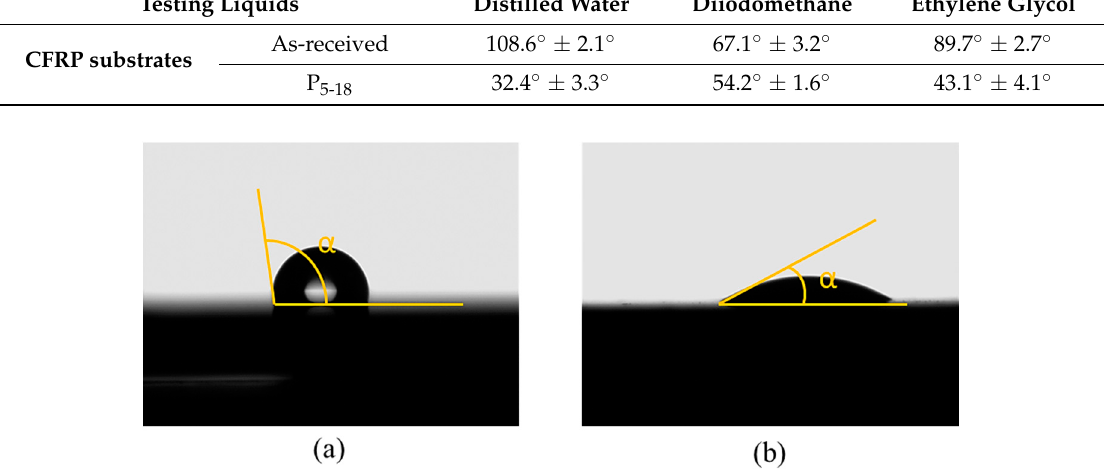
Figure 12. The contact angles of distilled water measured for ( a ) the as-received and ( b ) plasma-treated (P 5-18 ) CFRP substrates.